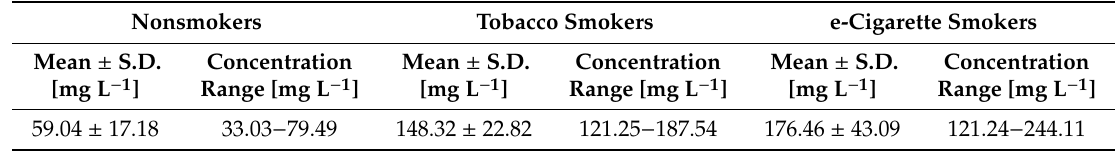
Table 5. Thiocyanate levels in human saliva of non-smokers, tabacco smokers, and e-cigarette smokers. Mean values of healthy donors are expressed in mg L − 1 , S.D. is the standard deviation.